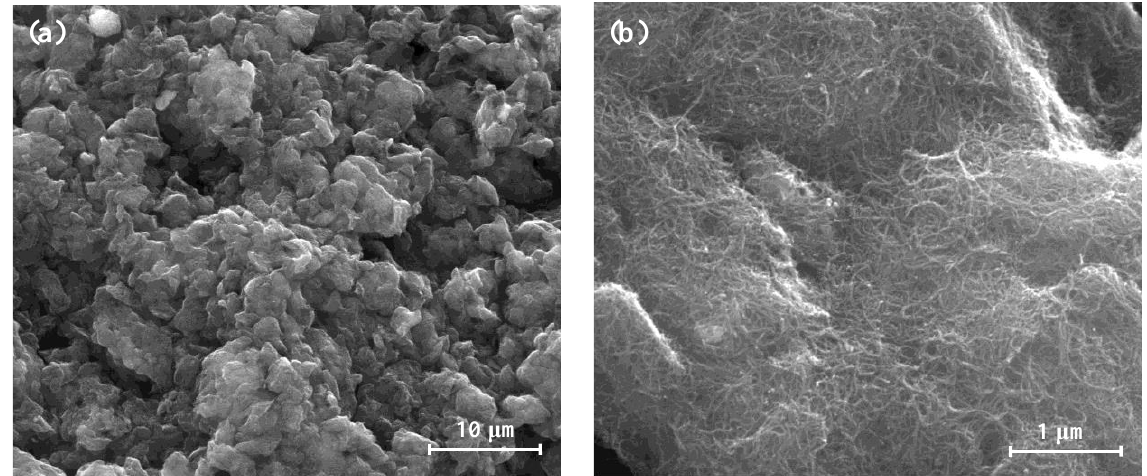
Figure 2. SEM images of Fe 2 Ni 2 @MWCNT_N6 at ×5000 ( a ) and ×50,000 ( b ) magnification.